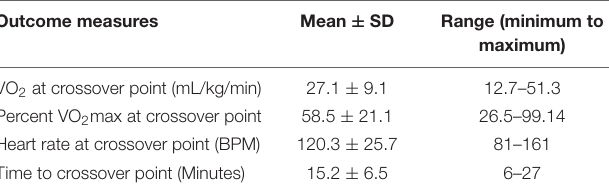
TABLE 3 | Outcome measures assessed during the submaximal graded exercise